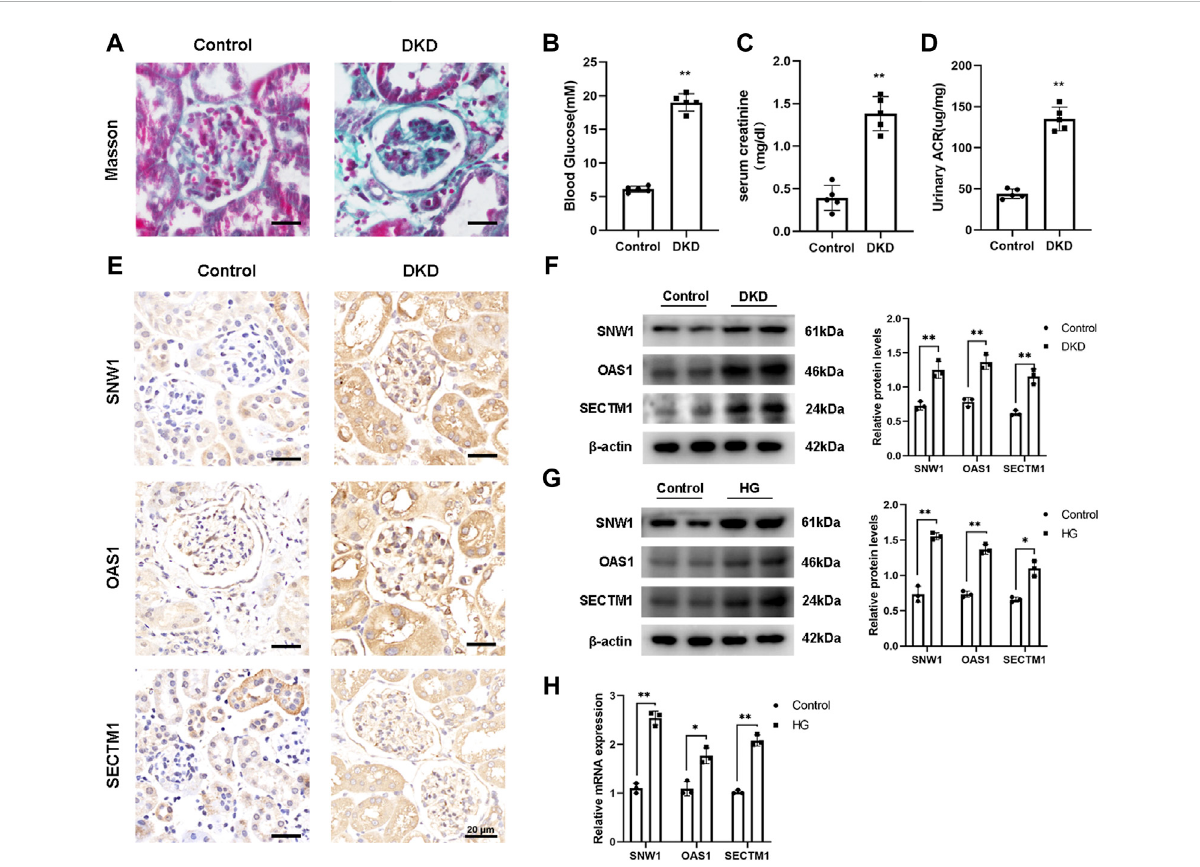
FIGURE 11 Validationofcoregeneexpression. (A) MassonstainingshowstypicalglomerularchangesinDKD. (B – D) Detectionofbloodglucoseandserum creatinine levels and urine albumin to creatinine ratio in mice. (E) Representative IHC staining of OAS1, SNW1, and SECTM1 in the control and DKD groups. (F – H) Detection of OAS1, SNW1, and SECTM1 expression by Western blot and qRT-PCR. p p < 0.05, pp p < 0.01 vs.